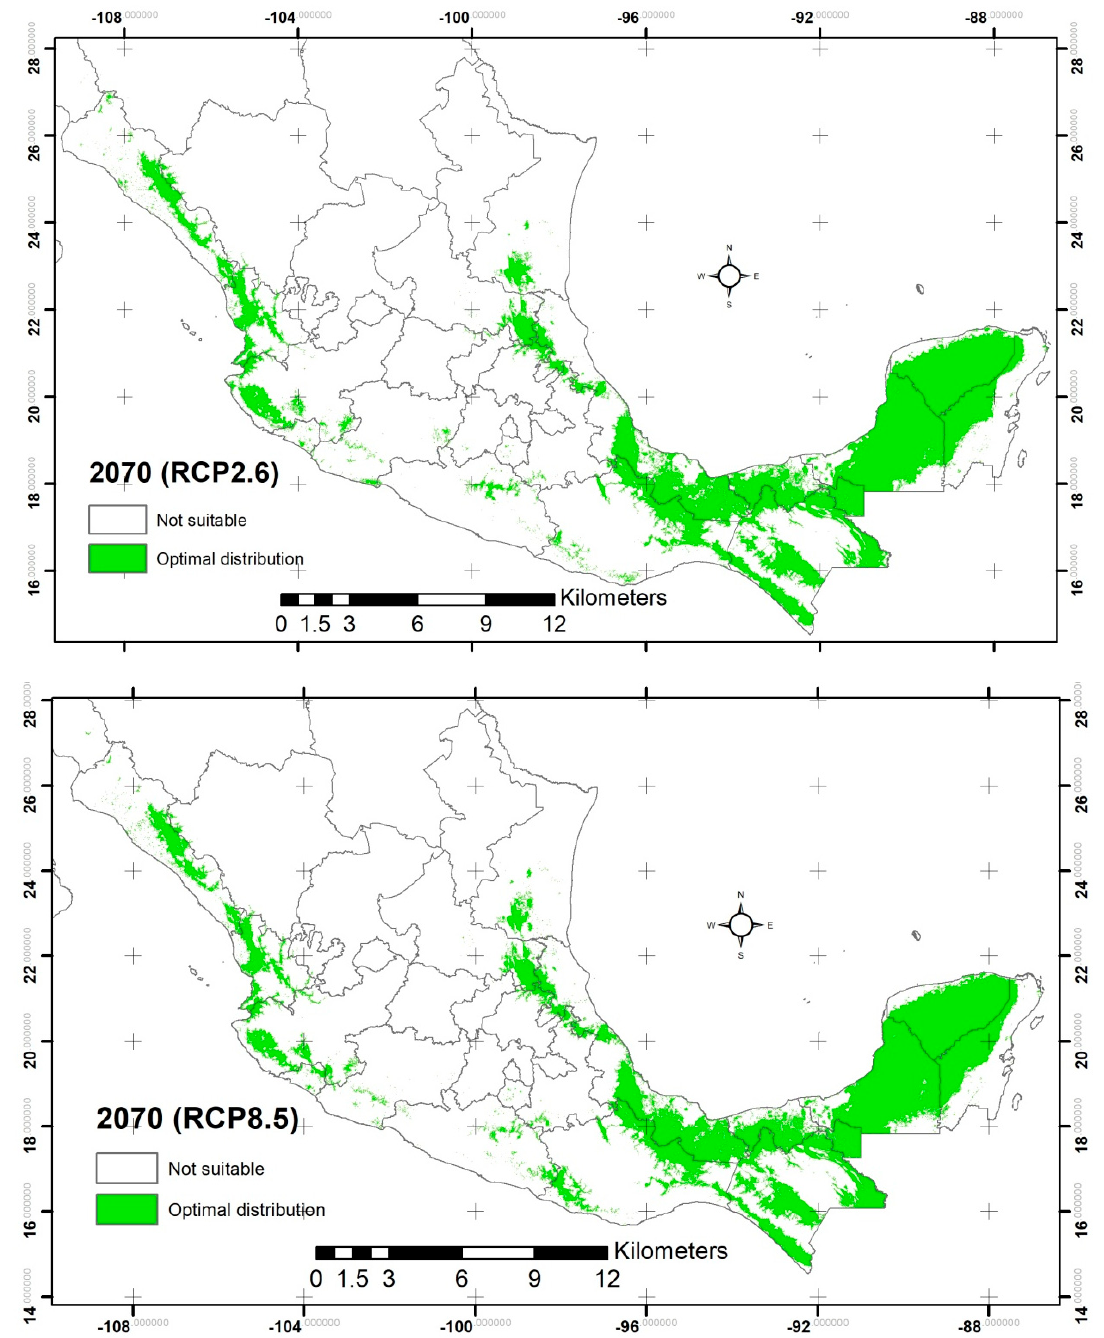
Figure 3. Potential distribution for the far future (2070) of C. odorata , in the NCAR model (CCSM4); for the conservative (RCP2.6) and drastic (RCP8.5) scenarios according to the optimal germination temperature range.